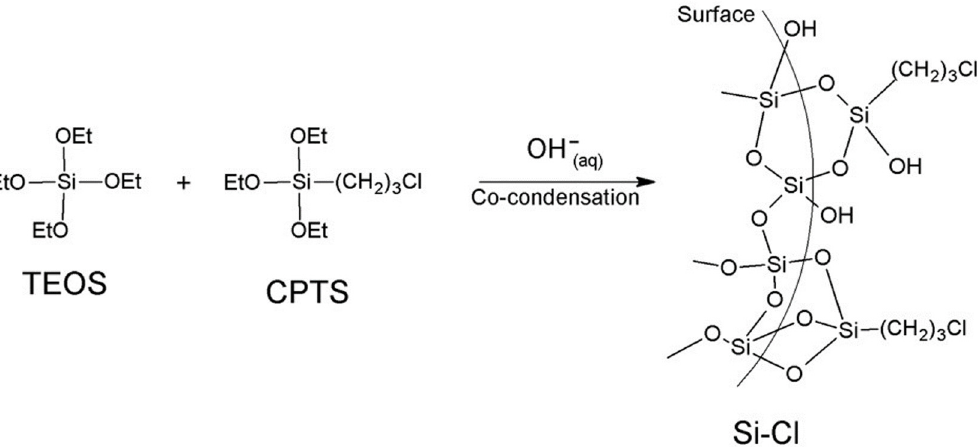
Figure 1. Co ‐ condensation reaction between TEOS and CPTS to produce the material Si ‐